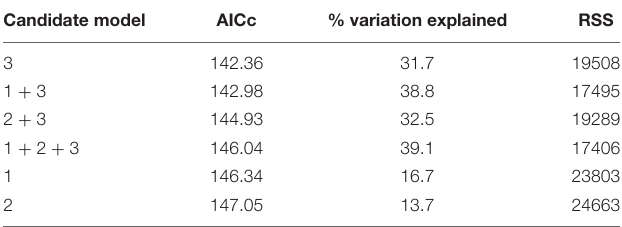
TABLE 1 | Distance-based linear models relating colony size (predictor 1), initial stage of the disease (predictor 2), and duration of the disease through time (predictor 3) to the degree of colony